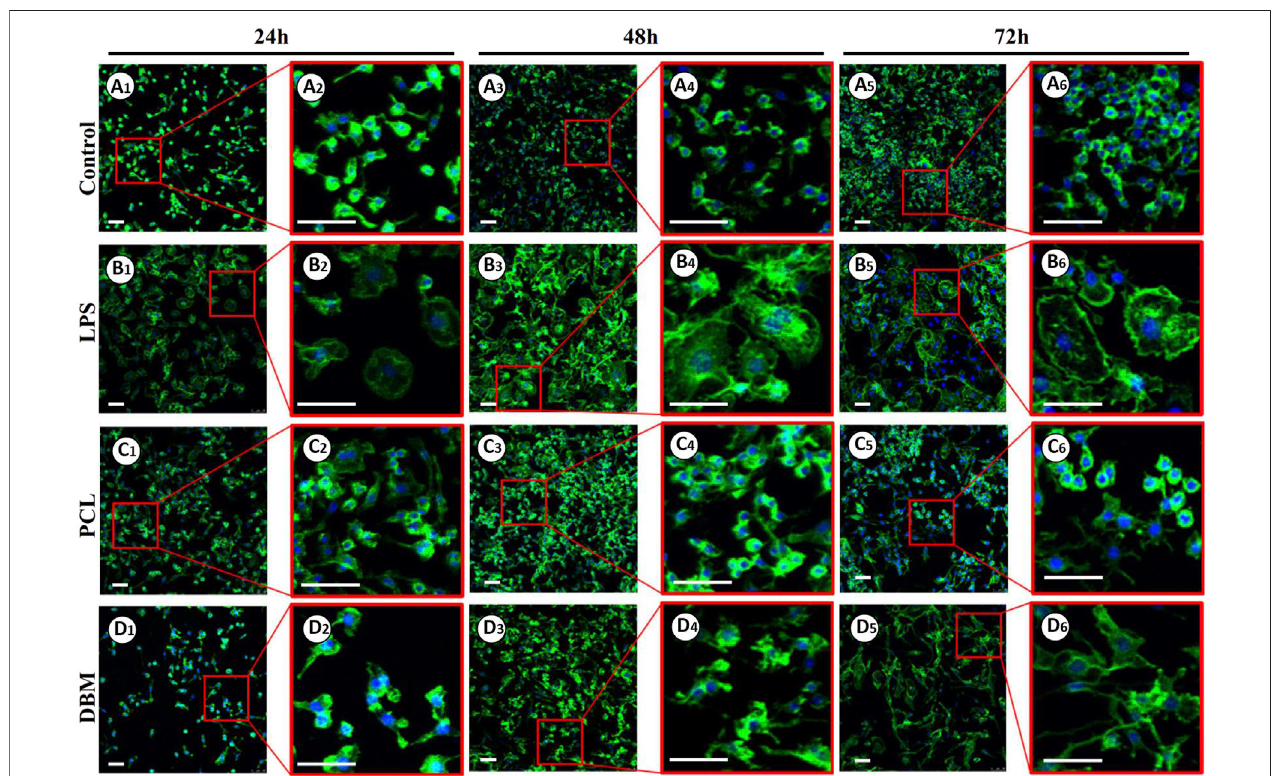
FIGURE 6 | Phalloidine immuno fl uorescence staining of RAW 264.7 cells treated by leach solutions of PCL and DBM frameworks: Negative control cultured in DMEM (A1 – A6) ; Positive control activated by LPS (B1 – B6) ; RAW 264.7 cells treated by PCL leach solution (C1 – C6) ; RAW 264.7 cells treated by DBM leach solution (D1 – D6) . Scale bar: 100 μ m.